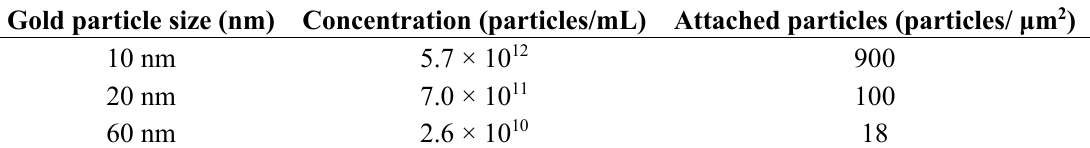
Figure 1. Attachment of gold particles on S2VP film after immersion for 2 h. The gold particle size is ( a , b ) 20 nm; ( c ) 10 nm; ( d ) 60 nm, respectively. The scale bar is 200 nm. Table 1. The number of attached gold particles with different particle sizes on S2VP film. Gold particle size